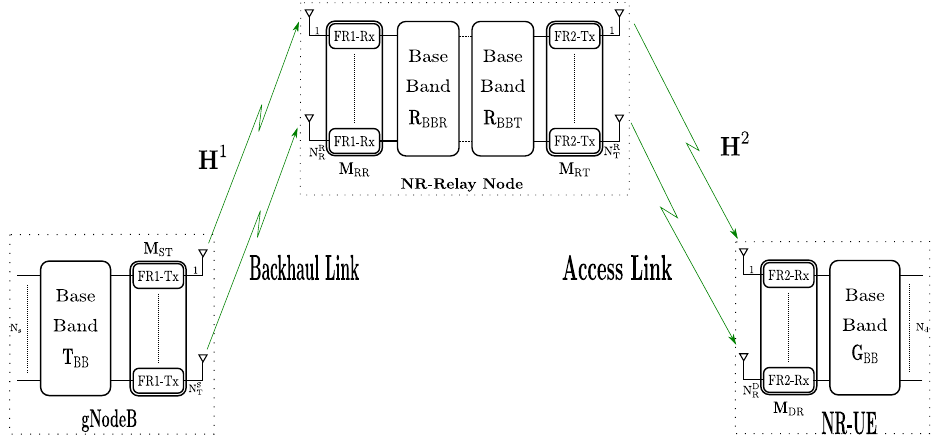
Figure 1. MIMO Millimeter-Wave (mmWave) downlink New Radio (NR)-Relay Node (RN)